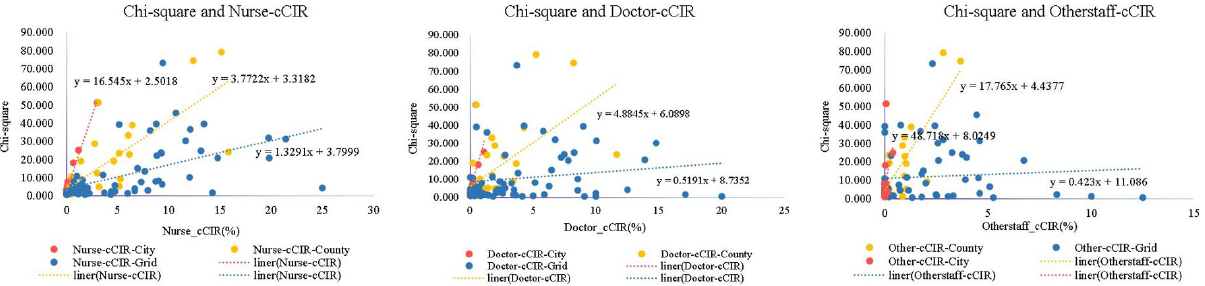
Figure 8. Infection rate and chi-square trend chart of different professions.